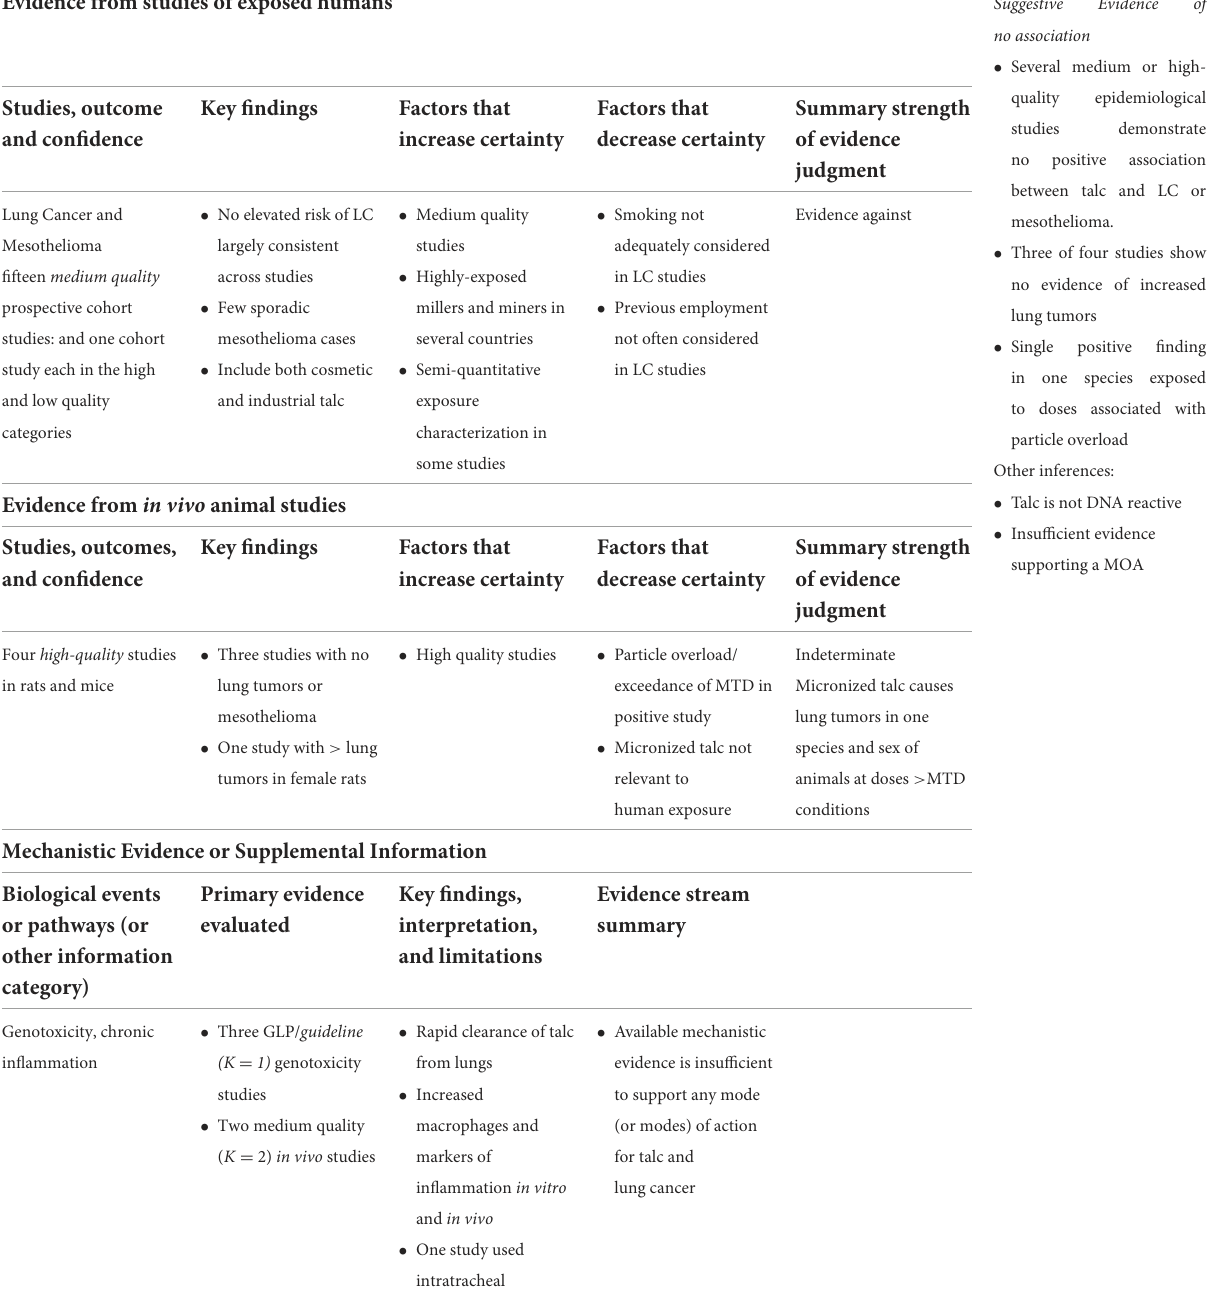
TABLE 2 Evidence integration summary judgment: lung cancer and